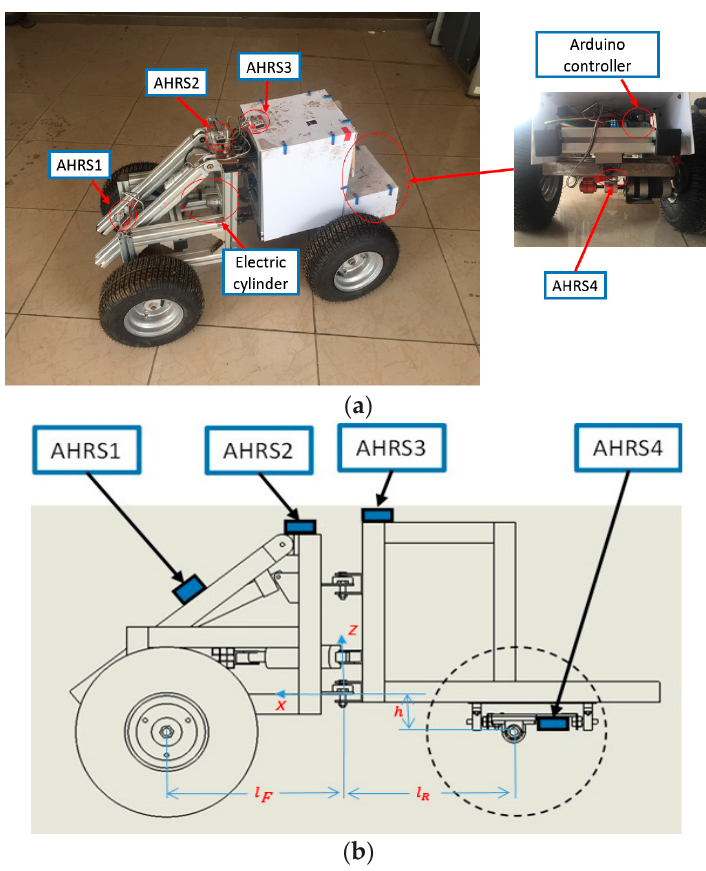
Figure 2. Scale prototype model for experiment and its sensor installation. ( a ) Scale down prototype model the actual installation location of four AHRS; ( b ) Sensor location and the location of some parameters.